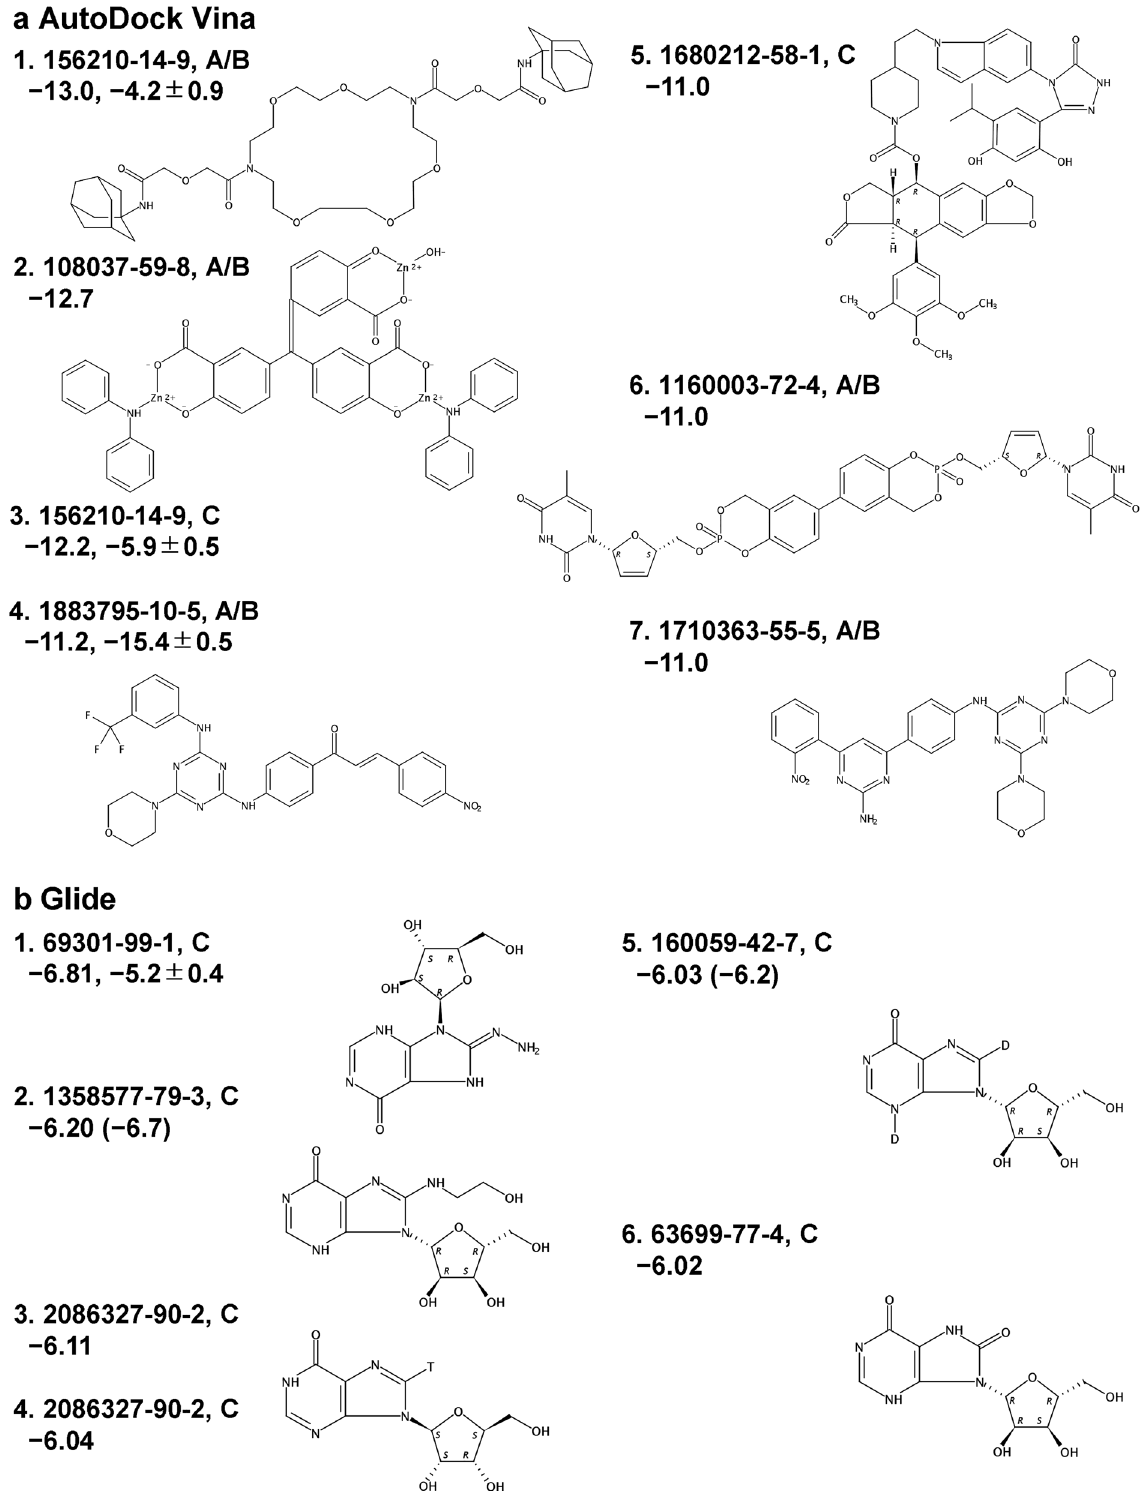
Figure 5. Top compounds identified by virtual screening. These compounds were screened from the antiviral compound library provided by The American Chemical Society (Mar. 2020) 62 using ( a ) AutoDock Vina 28 and ( b ) Schrödinger Glide 33 . Their ranking numbers, CAS Registry Number®, pockets (A/B or C), Vina or Glide scores, and standard binding free energies ( (cid:31) G o ) obtained by dPaCS-MD/MDM and 2D structures are shown. In ( b ), Vina scores are also shown in parentheses if AutoDock Vina scores were calculated. The Vina and Glide scores and (cid:31) G o are in kcal/mol. 2D structures were created by